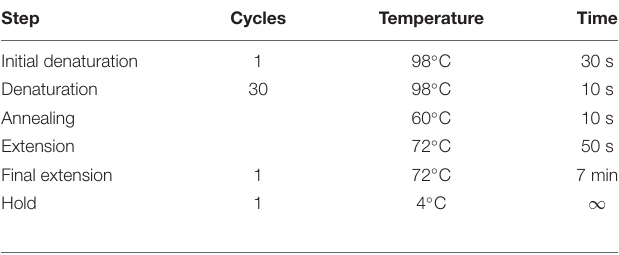
TABLE 1 | PCR cycling instructions for generating the AtIRE1a-KR PCR product.